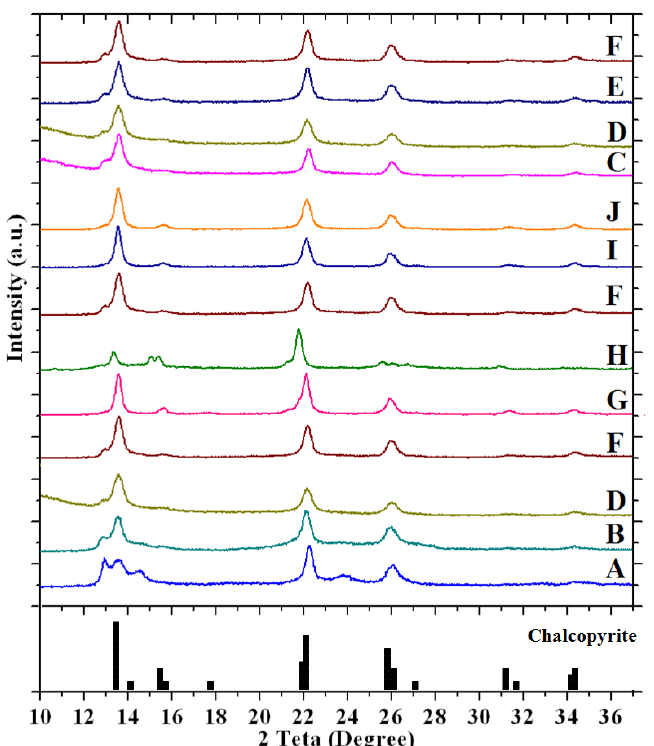
Fig. 1. PXRD patterns of the synthesized CuFeS